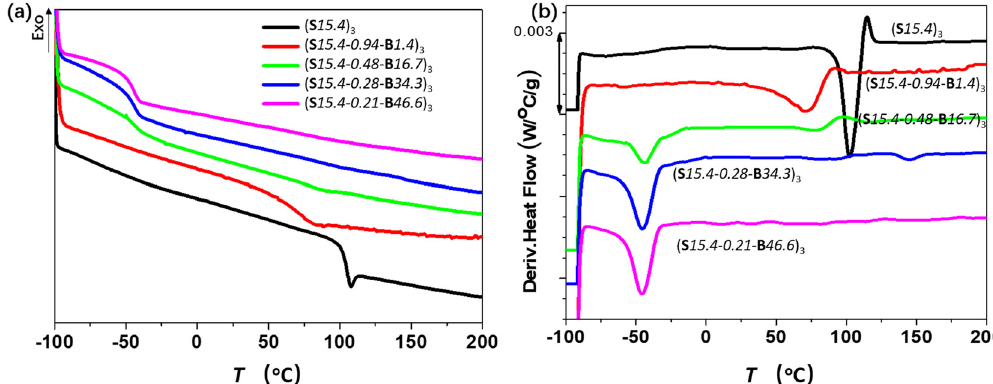
Figure 1: DSC curves for all the synthesized copolymers: S 46 , ( S 15.4 - 0.94 - B 1.4 ) 3 , ( S 15.4 - 0.48 - B 16.7 ) 3 , ( S .4 - 0.28 - B .3 ) 3 , and ( S .4 - 0.21 - B 46.6 ) ( a ) Heat fl ow of the synthesized polymer and ( b ) di ff erential of the heat fl ow versus temperature for all the block 3 . copolymers. These curves were obtained during the second heating